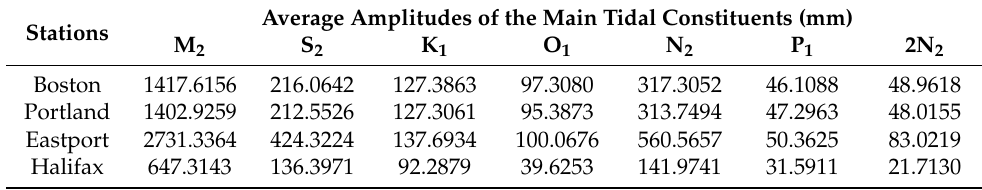
Table 2. Average amplitudes of the seven main tidal constituents at four tide gauges.